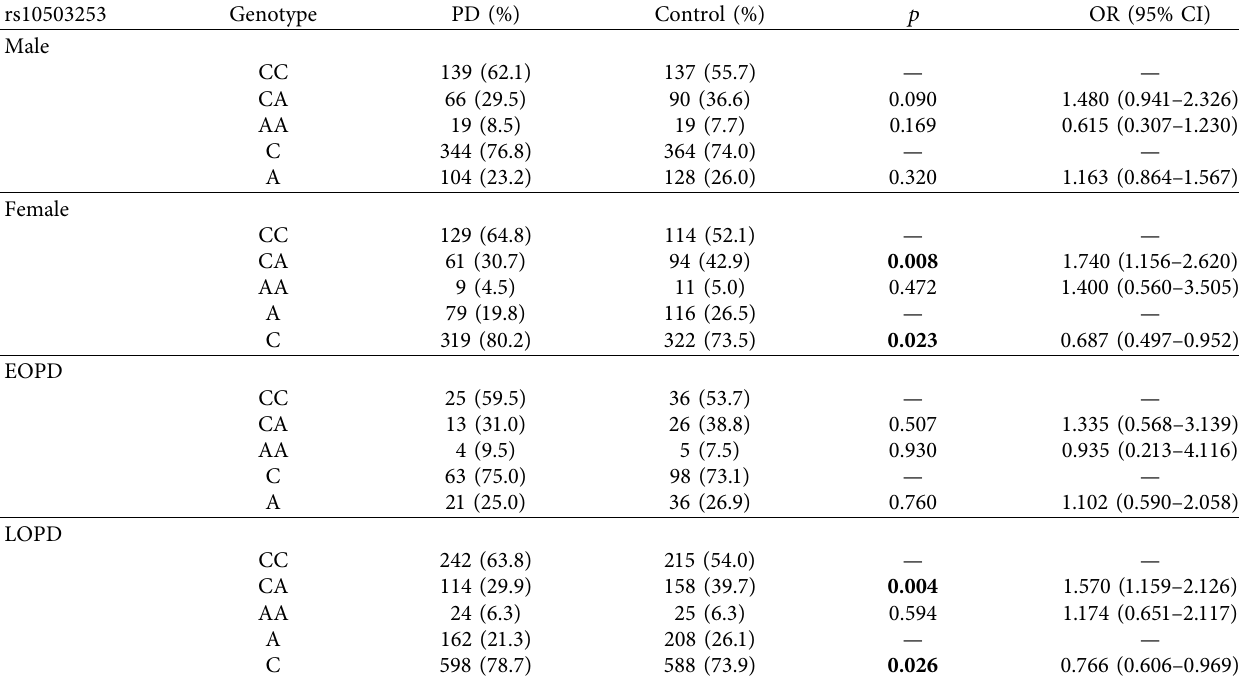
Table 5: Distributions of rs10503253 polymorphism in different subcomponent